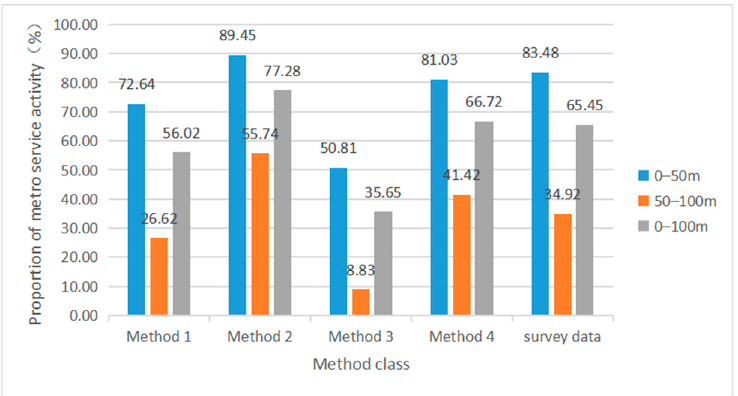
Figure 4. Proportion of metro service activity at different distance intervals for the four identification methods and travel survey data.